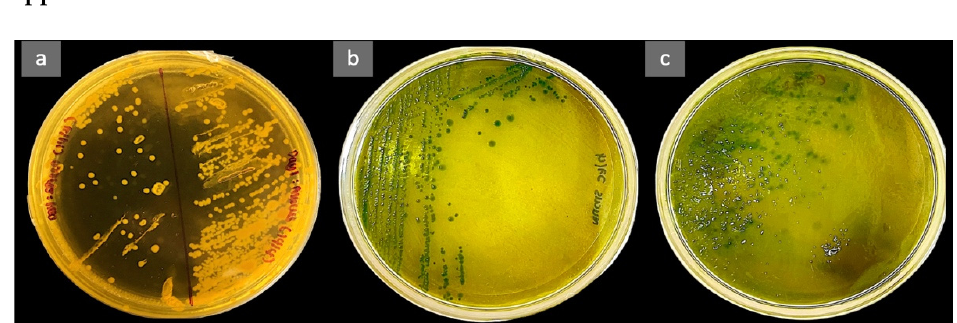
Figure A1. Bacteria isolated on the TCBS agar from the mucus and spleen of dead fish ( a ), mucus of the resistant ( b ), and susceptible ( c ) hybrid groupers.